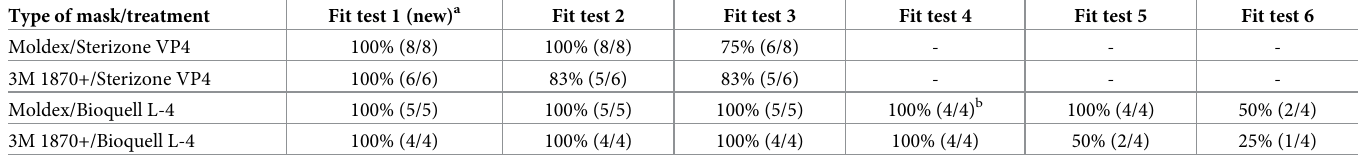
Table 2. Percentage of FFRs that passed fit tests after treatment.